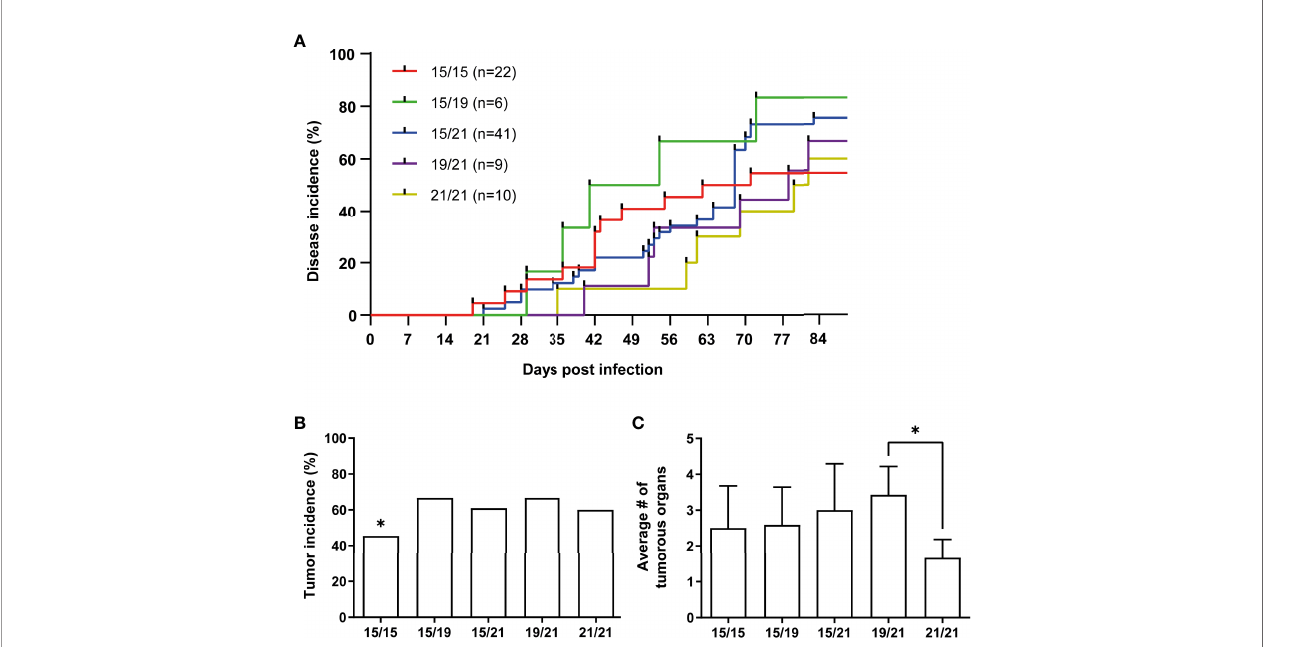
FIGURE 2 | (A) Kaplan-Meier analysis of Marek ’ s disease incidence (scored as clinical signs of the disease) in wild type virus infected chickens with different MHC haplotypes (n.s., Mantel – Cox test; n = 88). (B) Tumor incidences in infected chickens with different MHC haplotypes as percentage of chickens with macroscopic tumors from all chickens that were experimentally infected (*p ≤ 0.5 indicates signi fi cant difference of B15/15 to all other haplotypes, Chi-square test; n = 88). (C) Mean number of affected organs harboring gross tumors per infected chicken (*p ≤ 0.5, Kruskal-Wallis test with a Dunn ’ s multiple comparison post-hoc test; n =